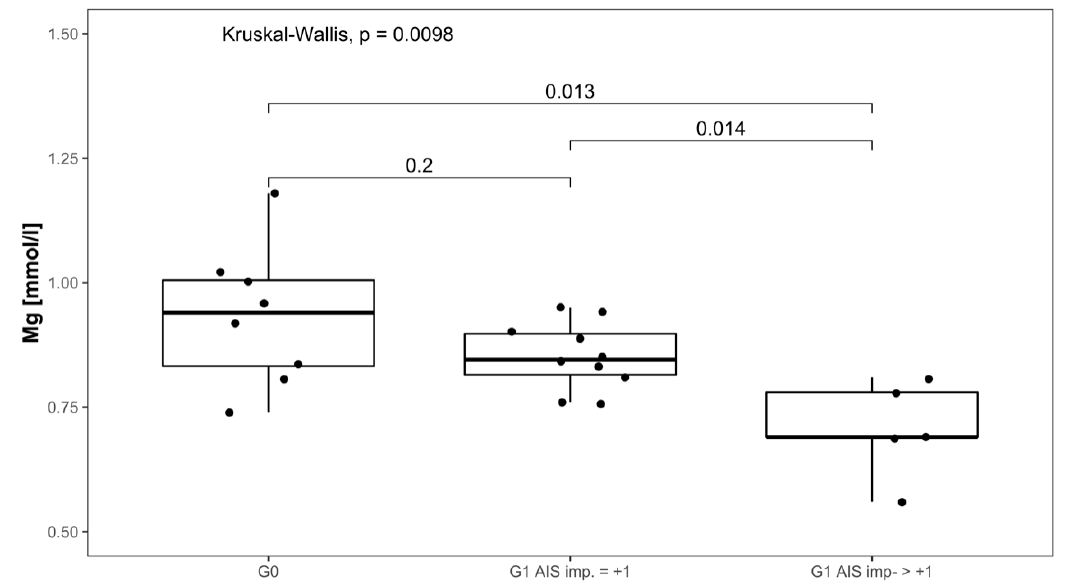
Figure 6. Mg serum level comparison of all patients at 1 week after injury in group G0 and patients with neurological remission that presented an AIS conversion of 1 level (G1 AIS imp. = +1) to those with an AIS level increase of more than 1 level (G1 AIS imp. > +1).